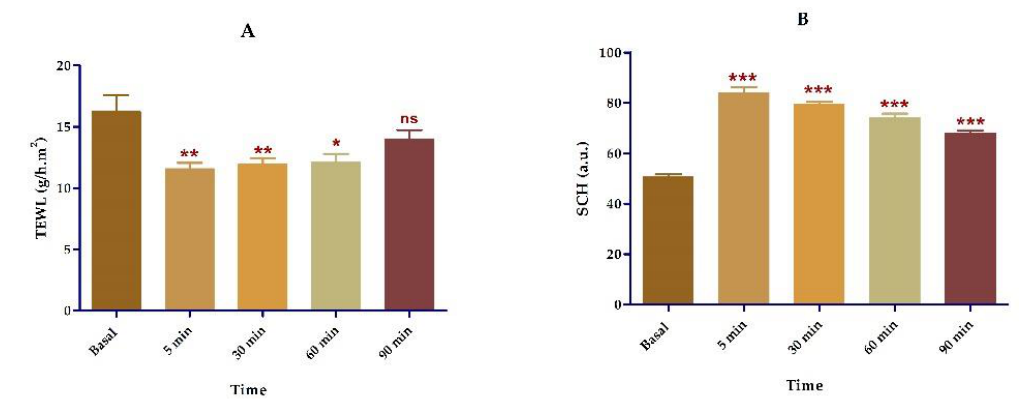
Figure 13. Tolerance studies in human individuals. ( A ) TEWL: Transepidermal water loss; ( B ) SCH: Stratum corneum hydration. Results are expressed as mean ± SD ( n = 12). Statistically significant differences in comparison with basal state: *, p < 0.05; **, p < 0.01; ***, p < 0.001; ns, not significant.